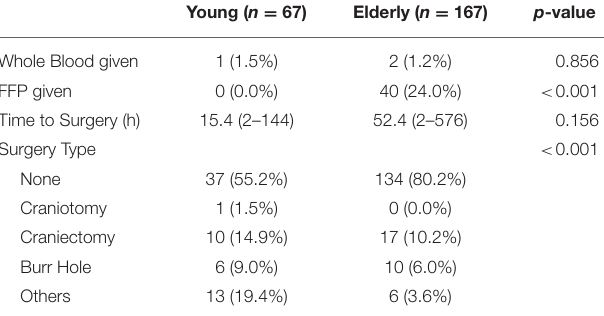
TABLE 5 | Surgical intervention.